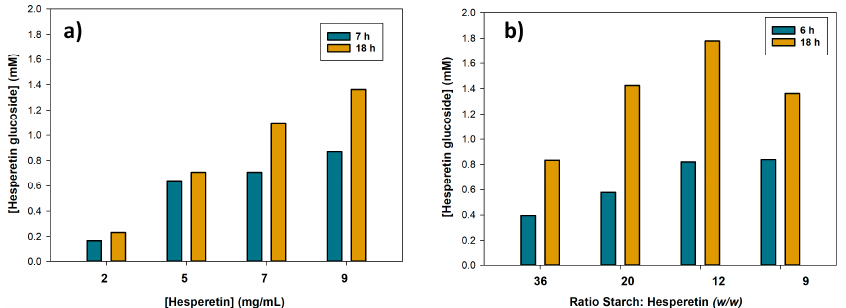
Figure 6. Effect of the concentrations of soluble starch and hesperetin on the glucosylation. ( a ) Maintaining a ratio 20:1 w / w starch/hesperetin; ( b ) Fixing the concentration of partially hydrolyzed starch (180 mg/mL) and varying the amount of hesperetin. Reaction conditions: hesperetin (2–20 mg/mL), soluble starch (24–180 mg/mL), CGTase from Thermoanaerobacter sp. (10% v / v ), bis(2-methoxyethyl) ether (30 % v / v ), 10 mM sodium citrate buffer pH 5.0 (60% v / v ), 60 °C, 1000 rpm.